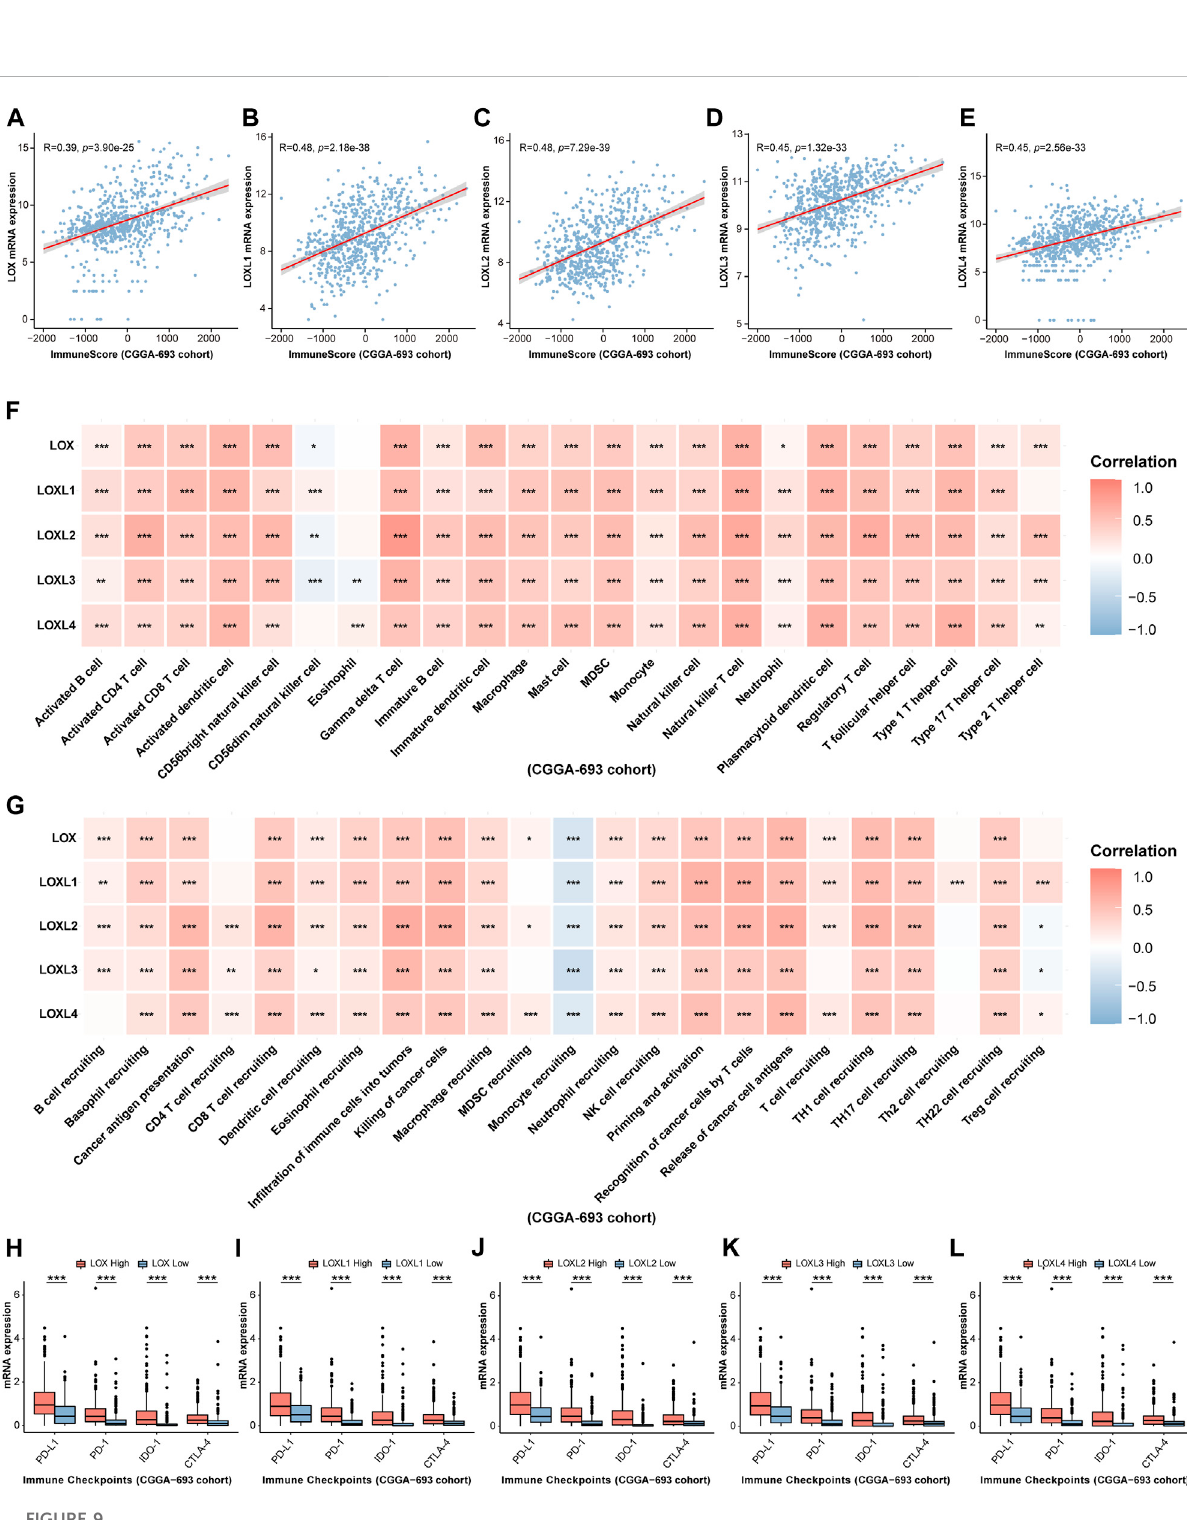
FIGURE 9 Validation of the relationship between LOXs expressions and immune response in glioma in CGGA-693 cohort. (A – E) Correlation between differential LOXs expressions and immune score in glioma in CGGA-693; (F,G) relationship between differential expressions of LOXs and immune in fi ltrationscore orcancerimmunitycycles ingliomainCGGA-693; (H – L) relationshipbetweendistinct LOXsexpressionsandimmune checkpoints (including PD-L1, PD-1, IDO-1, and CTLA-4) in glioma in